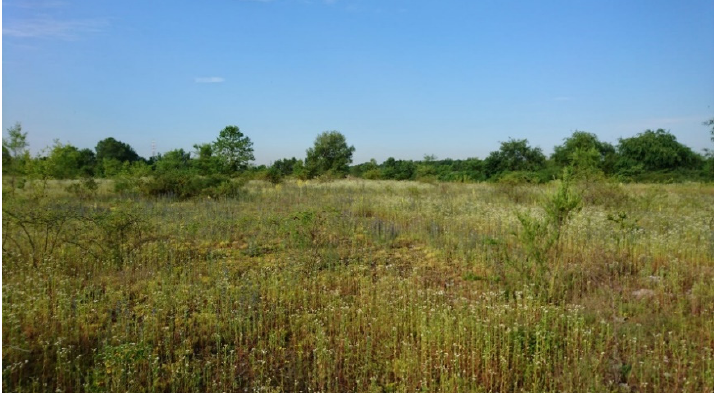
Figure 4. Malpaga-Basella Nature Reserve, station 3, with the largest number of plant species, a higher number of shrubs and invasive species (photo P. Gaini).